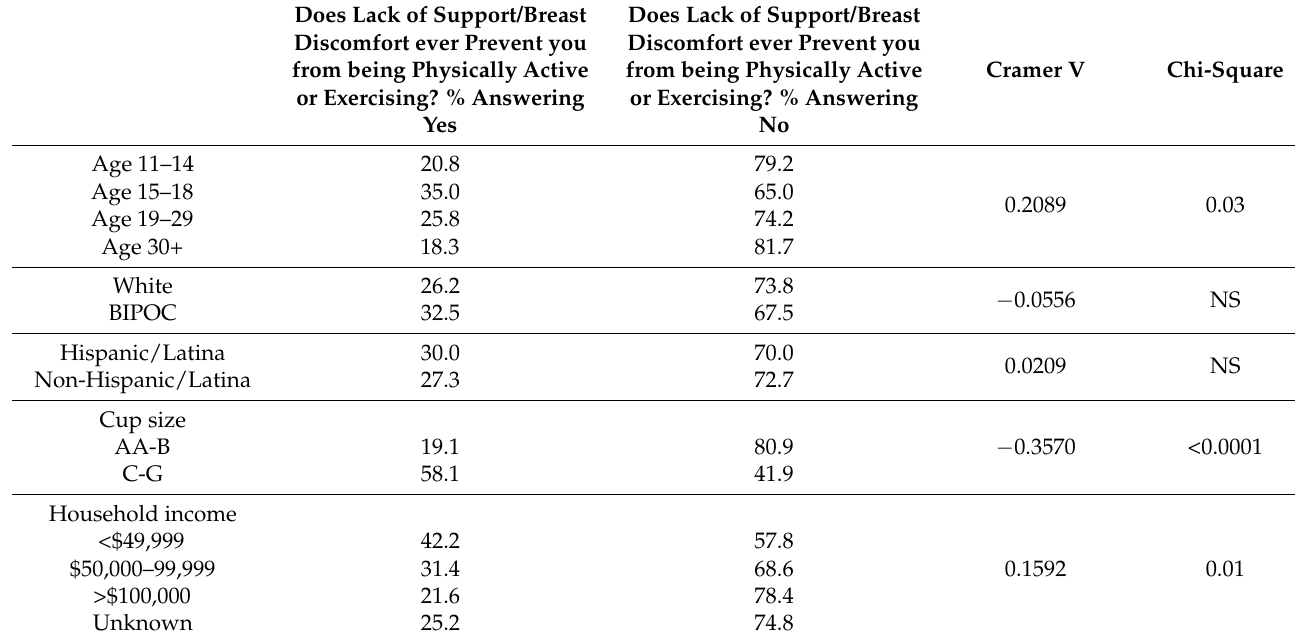
Table 3. Breast support and exercise/physical activity